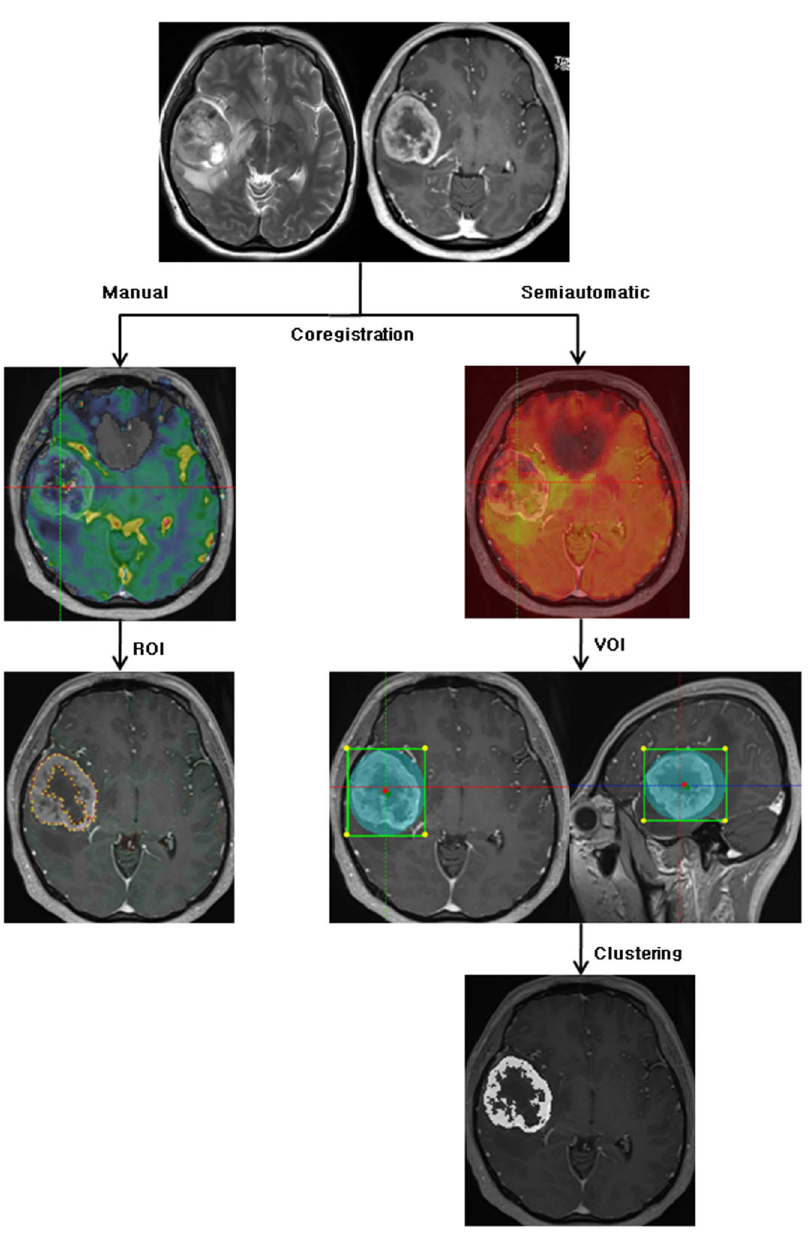
Figure 2. Flowchart of manual and semiautomatic segmentation analysis. Structural imaging (CE-T1WI or T2WI) and nCBV maps were coregistered using the manual segmentation method, and then the ranges of tumors were manually depicted by each observer using an ROI (right row) . Structural imaging (CE-T1WI or T2WI) and nCBV maps were coregistered using the semiautomatic segmentation method; then, the ranges of tumors were depicted by each observer using a VOI. Finally, an appropriate combination of clusters from the various clusters was determined by each observer (left row) . CE-T1WI=contrast enhanced T1-weighted imaging; T2WI=T2-weighted imaging; nCBV=normalized cerebral blood volume; ROI=region of interest; VOI=volume of